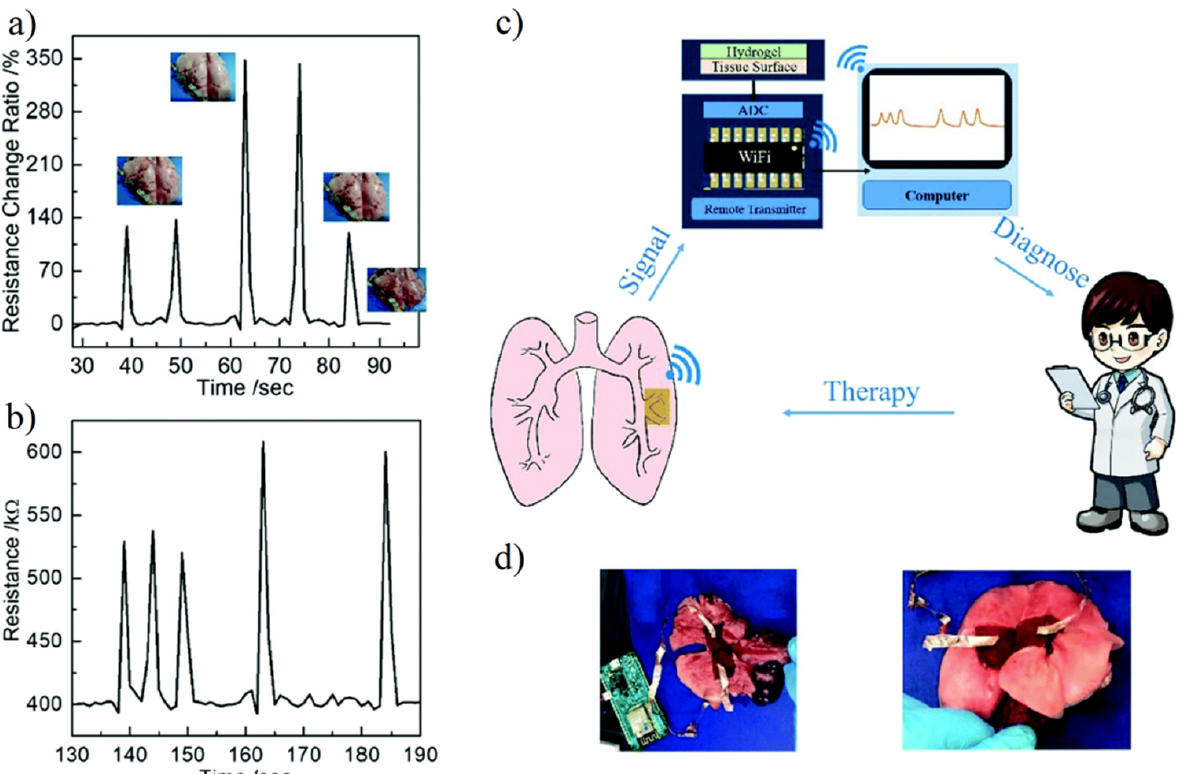
Figure 16. Hydrogel sensors for real-time monitoring and simulated lung breathing. ( a , b ) Wired transmission ( a ) and wireless transmission ( b ) of the resistance from simulated lung breathing. No significant signal differences were collected in wired or wireless transmission in term of sensitivity. ( c ) Schematic illustration of wireless monitoring of lung breathing. ( d ) Images of rabbit lungs with wired (left) or wireless (right) transmission hydrogel sensor. Reproduced with permission from